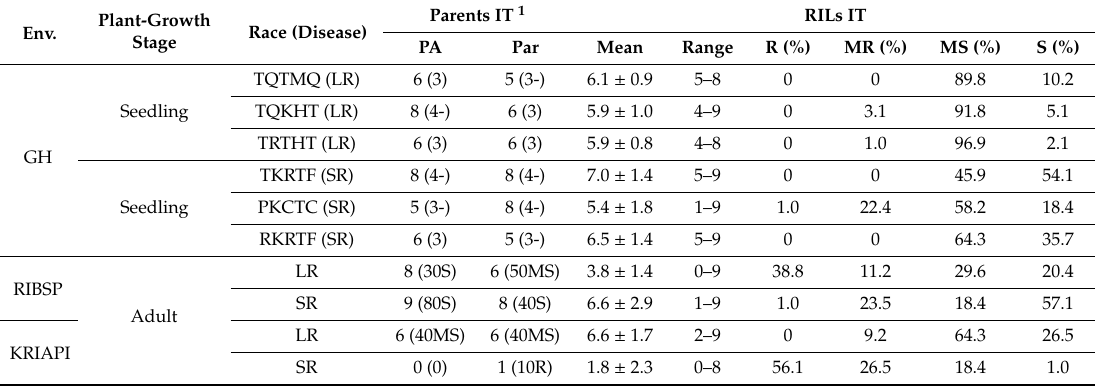
Table 3. Descriptive statistics for leaf rust (LR) and stem rust (SR) resistance at two plant-growth stages in the Pamyati Azieva × Paragon mapping